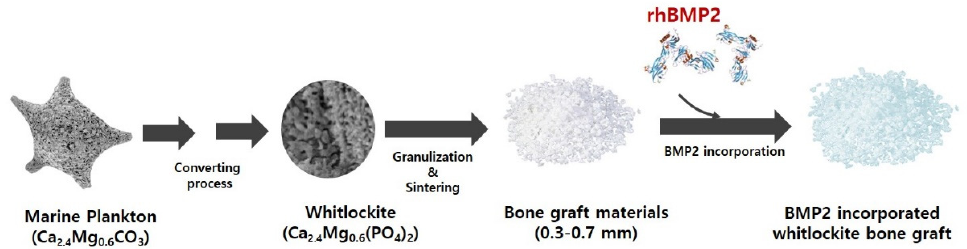
Figure 10. Schematic of the BMP2-incorporating marine-plankton-derived WH bone granules.